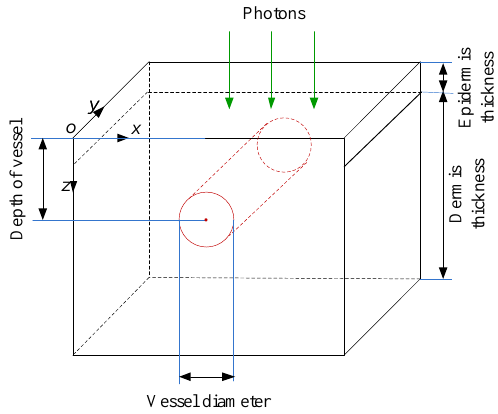
Figure 4. Three boundary conditions (BCs) for laser transportation. The computational domain is marked by a black rectangle. ( a ) Reflecting BC, ( b ) Escape BC and ( c ) Extended BC. The red dashed line represents the terminated photon.